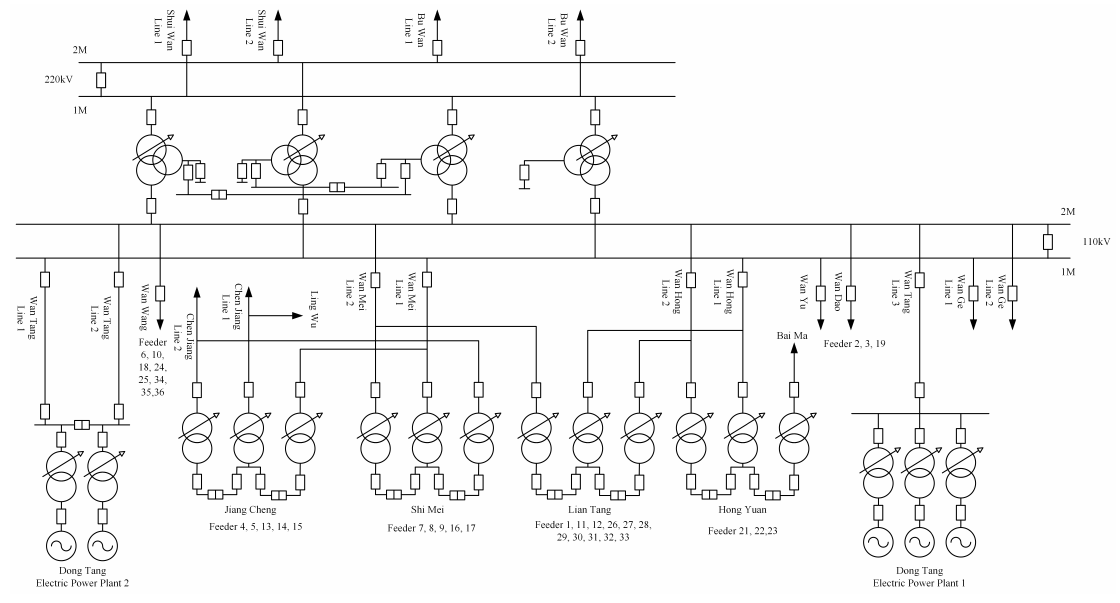
Figure 3. Primary electrical system in Wanjiang area above 110 kv, including electric power plants, transmission buses, converting stations, and user loads. The feeders are marked under their corresponding load sides.